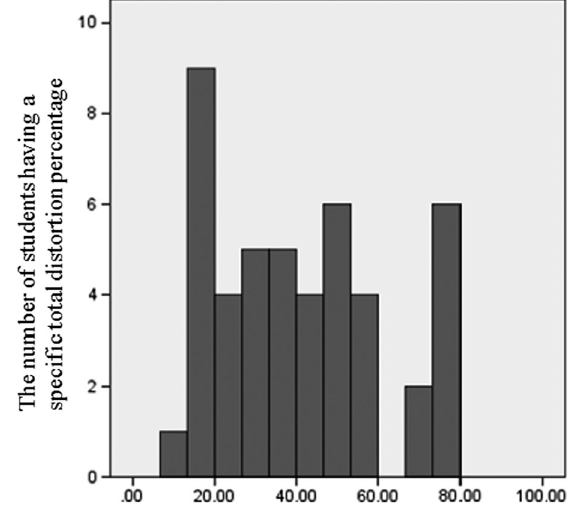
FIG. 2. Distribution of distortion percentages ( N ¼